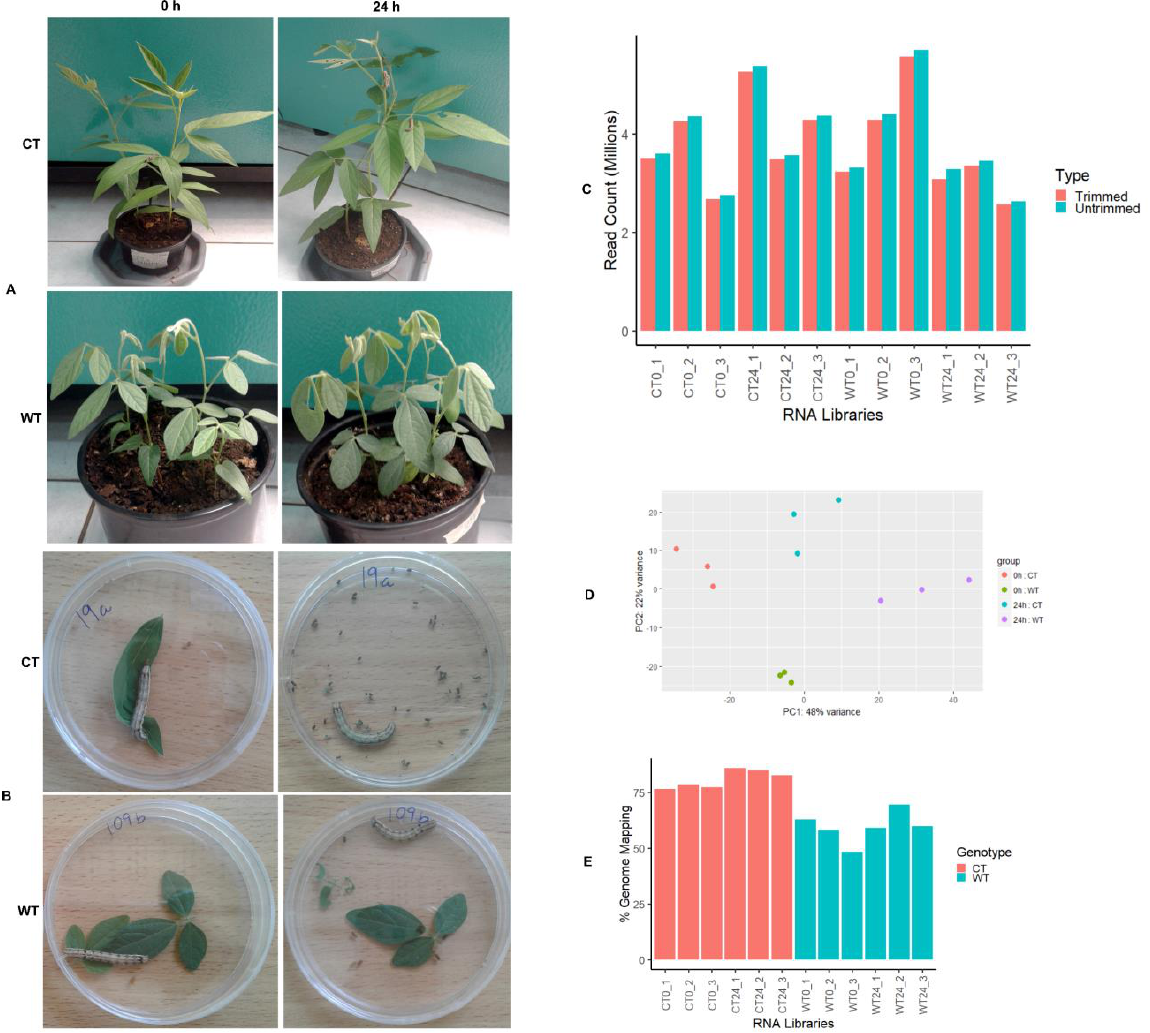
Figure 1. Helicoverpa armigera bioassays and high-throughput sequencing of cultivated pigeonpea (KAT 60/8) and wild relative ( Cajanus scarabaeoides ). ( A ) Whole plant bioassay and ( B ) detached leaves bioassay. ( C ) Reads distribution statistics of sequenced libraries. ( D ) Principal component analysis (PCA) plot showing the clustering of sequenced libraries, and ( E ) percentage reads mapping of cultivated and wild relative genotypes against the pigeonpea